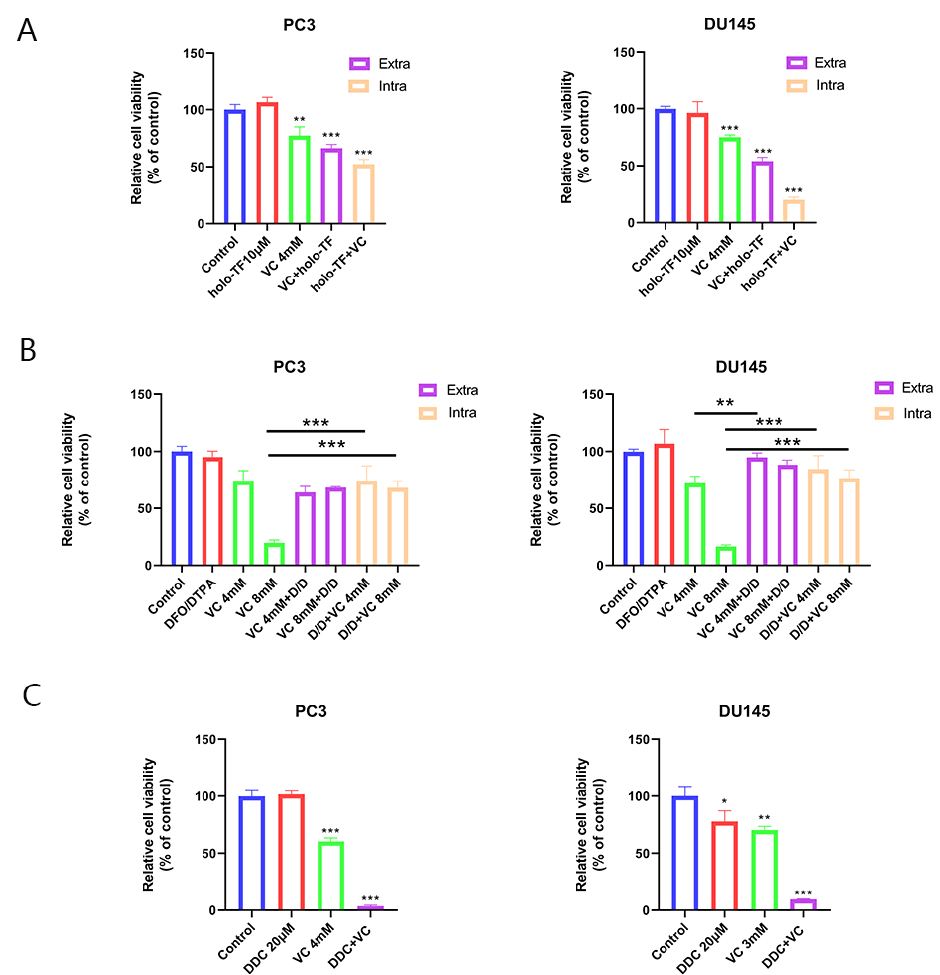
Figure 3. Iron supplementation enhances cytotoxicity induced by VC, which could be protected by iron chelators. ( A ) Relative cell viability of PC3 and DU145 cells after being pre-treated with 10 µ M holo-TF for 3 h, washed with PBS and then treated with 4 mM VC for 3 h (iron supplementation intracellular) or co-exposure to 10 µ M holo-TF and 4 mM VC for 3 h (iron supplementation extracellular). ( B ) PC3 and DU145 cells were pre-treated with 200 µ M DFO and 1 mM DTPA (D/D) for 3 h followed by exposure for 3 h to 4/8 mM VC, or co-exposure to D/D and 4/8 mM VC for 3 h. ( C ) PC3 and DU145 cells were treated with different doses of VC alone or combined with 20 µ M DDC for 3 h. * p < 0.05, ** p < 0.01, *** p < 0.001.